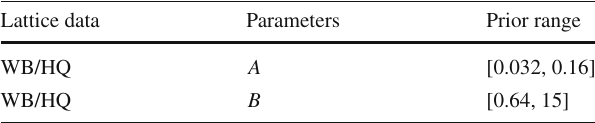
Table 3 The ranges of model parameters ( A , B ) used in the prior